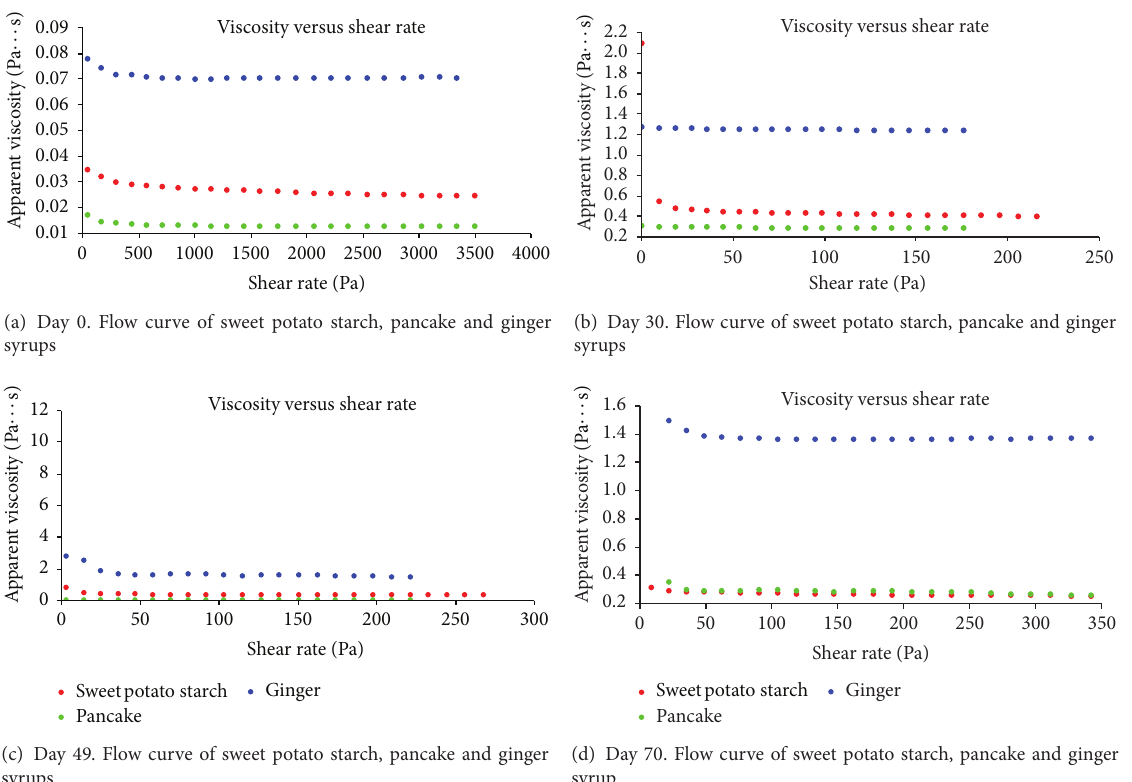
(d) Day 70. Flow curve of sweet potato starch, pancake and ginger syrup